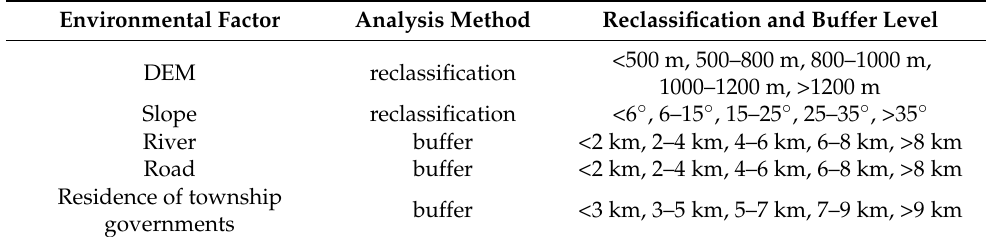
Table 1. Different environmental factor reclassifications and buffer levels.